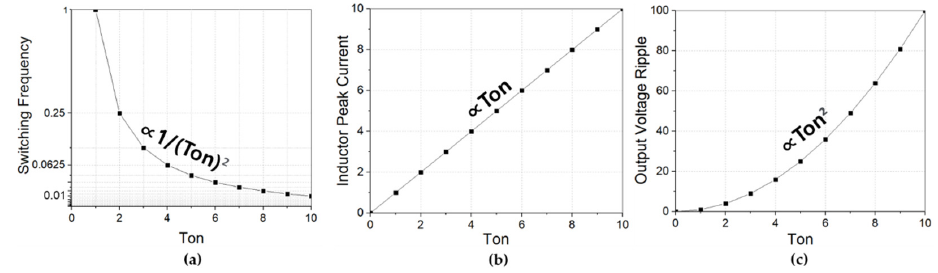
Figure 4. Selectable adaptive on-time characteristics: ( a ) relationship between on-time and switching frequency, ( b ) relationship between on-time and inductor peak current, and ( c ) relationship between on-time and output voltage ripple.